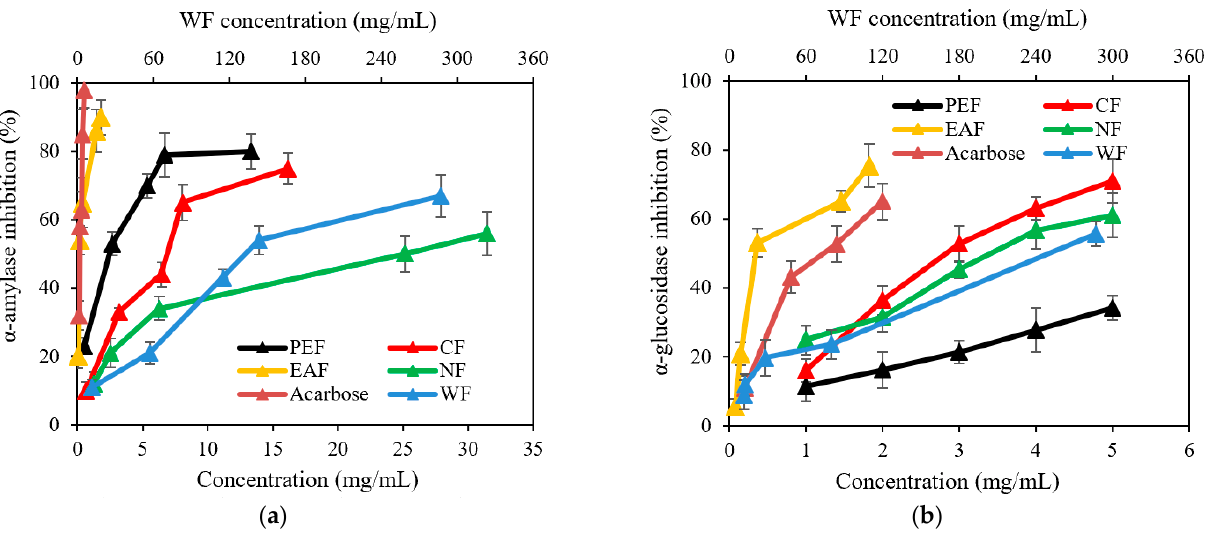
Figure 2. α -Amylase inhibitory effects ( a ) and α -glucosidase inhibitory effects ( b ) of each extracted fractions from Pingguoli pear fermentation broth with different concentrations. Values are mean ± SD ( n = 3). Table 3. IC 50 values of α -amylase and α -glucosidase inhibition by five extracted fractions from Pingguoli pear fermentation broth.